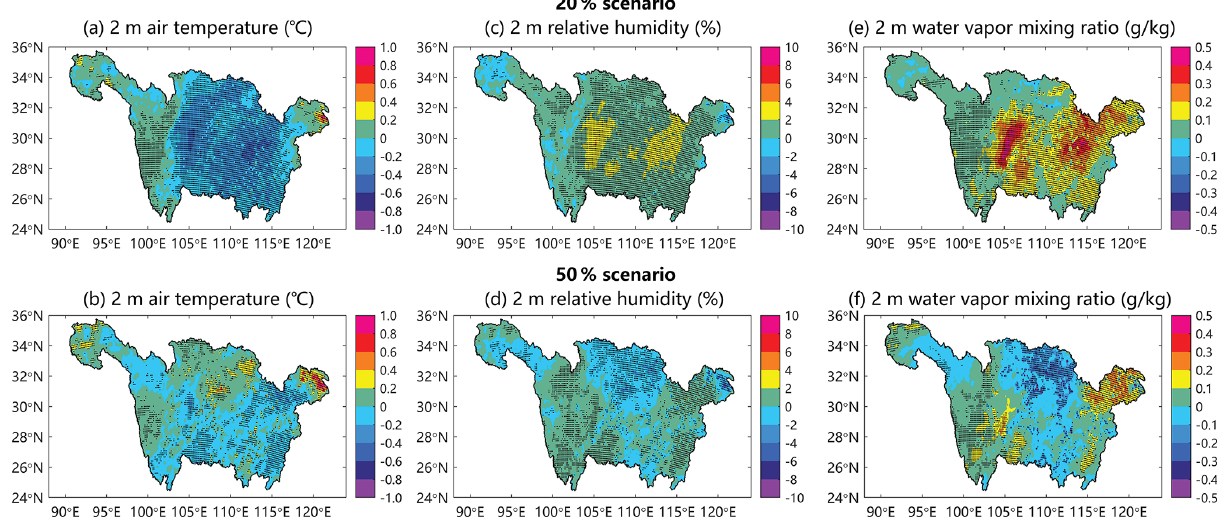
Figure 14. The changes in (a, b) 2m air temperature ( ◦ C), (c, d) 2m relative humidity (%), and (e, f) 2m water vapor mixing ratio (gkg − 1 ) between the 20% scenario and the 2010 scenario and between the 50% scenario and the 2010 scenario. The stippled regions show statistical significance of the changes identified by the t test at a 5% significance